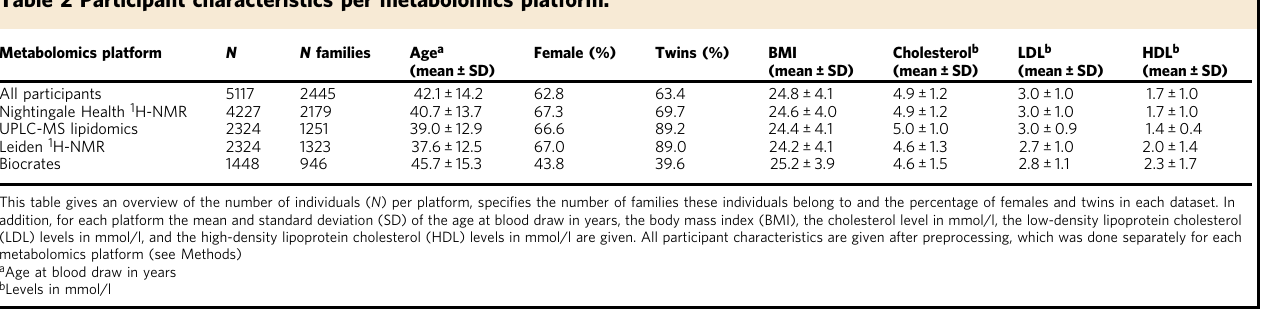
Table 2 Participant characteristics per metabolomics platform.